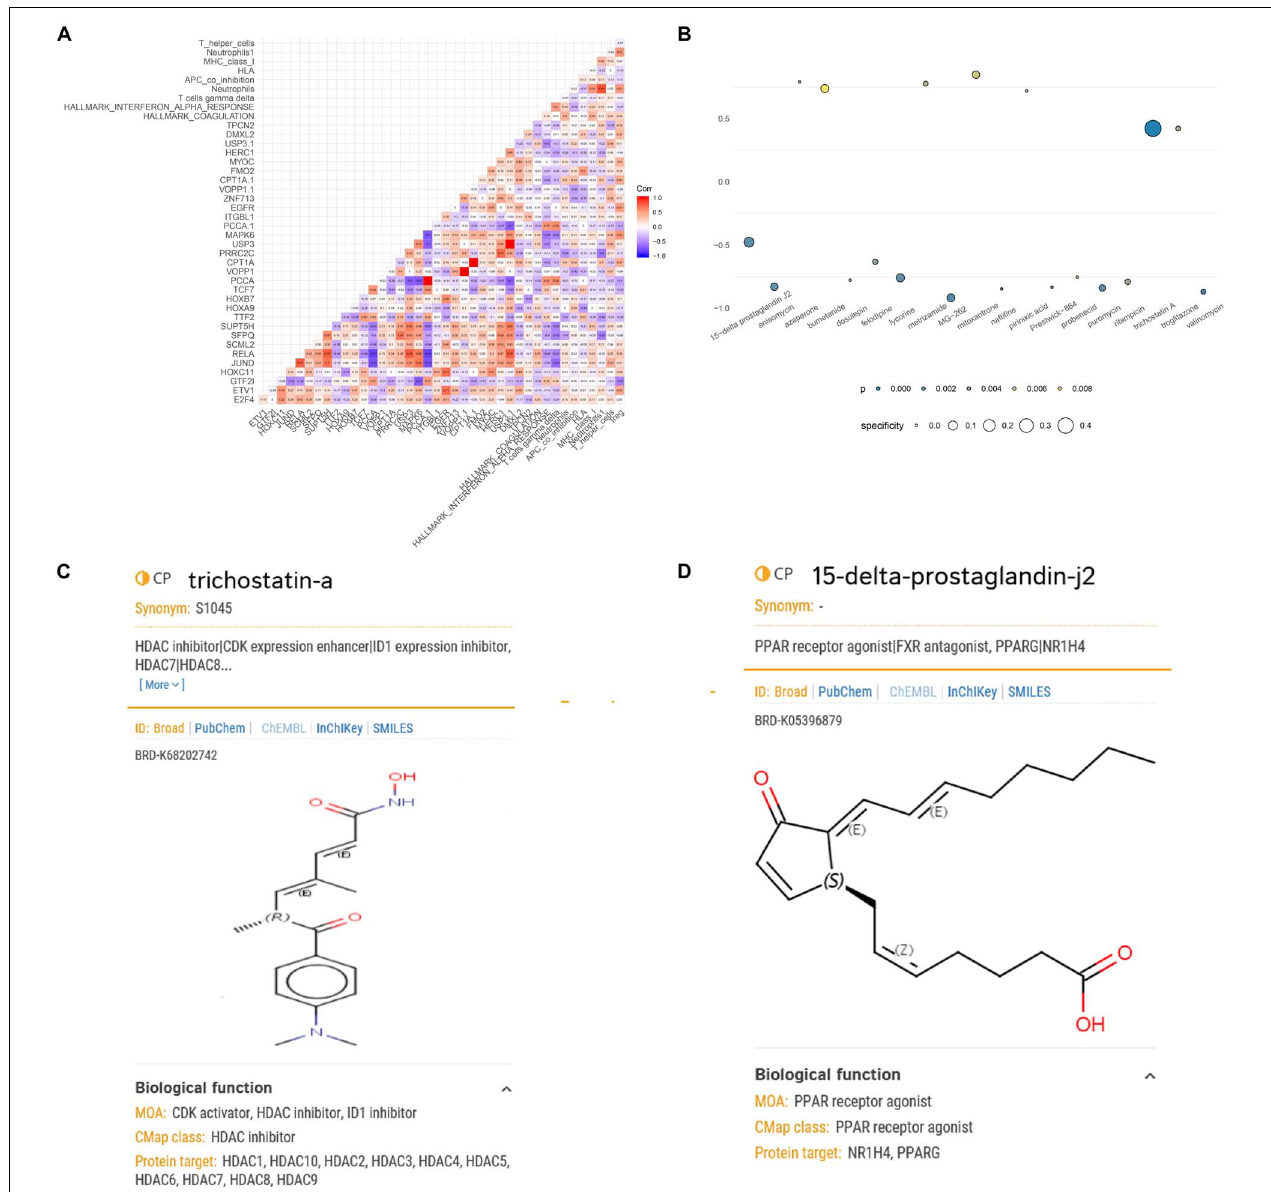
FIGURE 6 | Correlation analysis of the key biomarkers and identification of potential small-molecule drugs for spinal cord injury (SCI). (A) Heat map showing the results of correlation analysis (Pearson analysis) of enhancer RNAs (eRNAs), transcription factors (TFs), target genes, immune cells/pathways, and hallmark pathways. (B) Heat map showing perturbagens from the Connectivity Map (CMap) that might be capable of targeting SCI-related eRNAs. (C) Structural formula of trichostatin A. (D) Structural formula of 15-delta prostaglandin